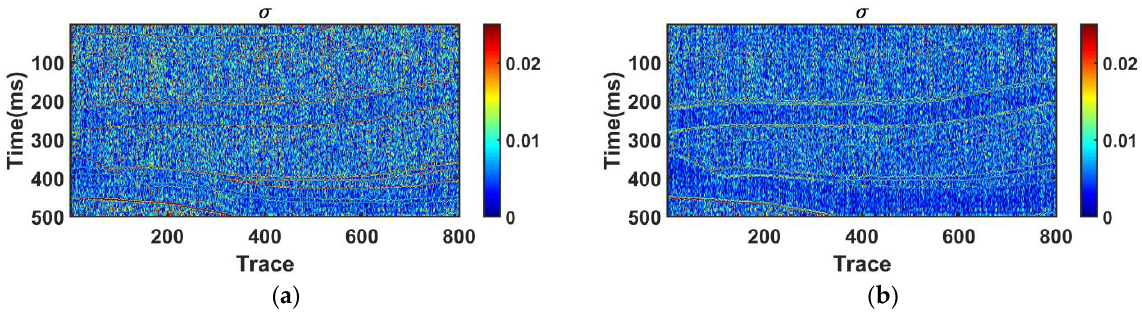
Figure 19. Poisson's ratio inversion error after adding noise based on (a) traditional method and (b) reweighted Lp method.